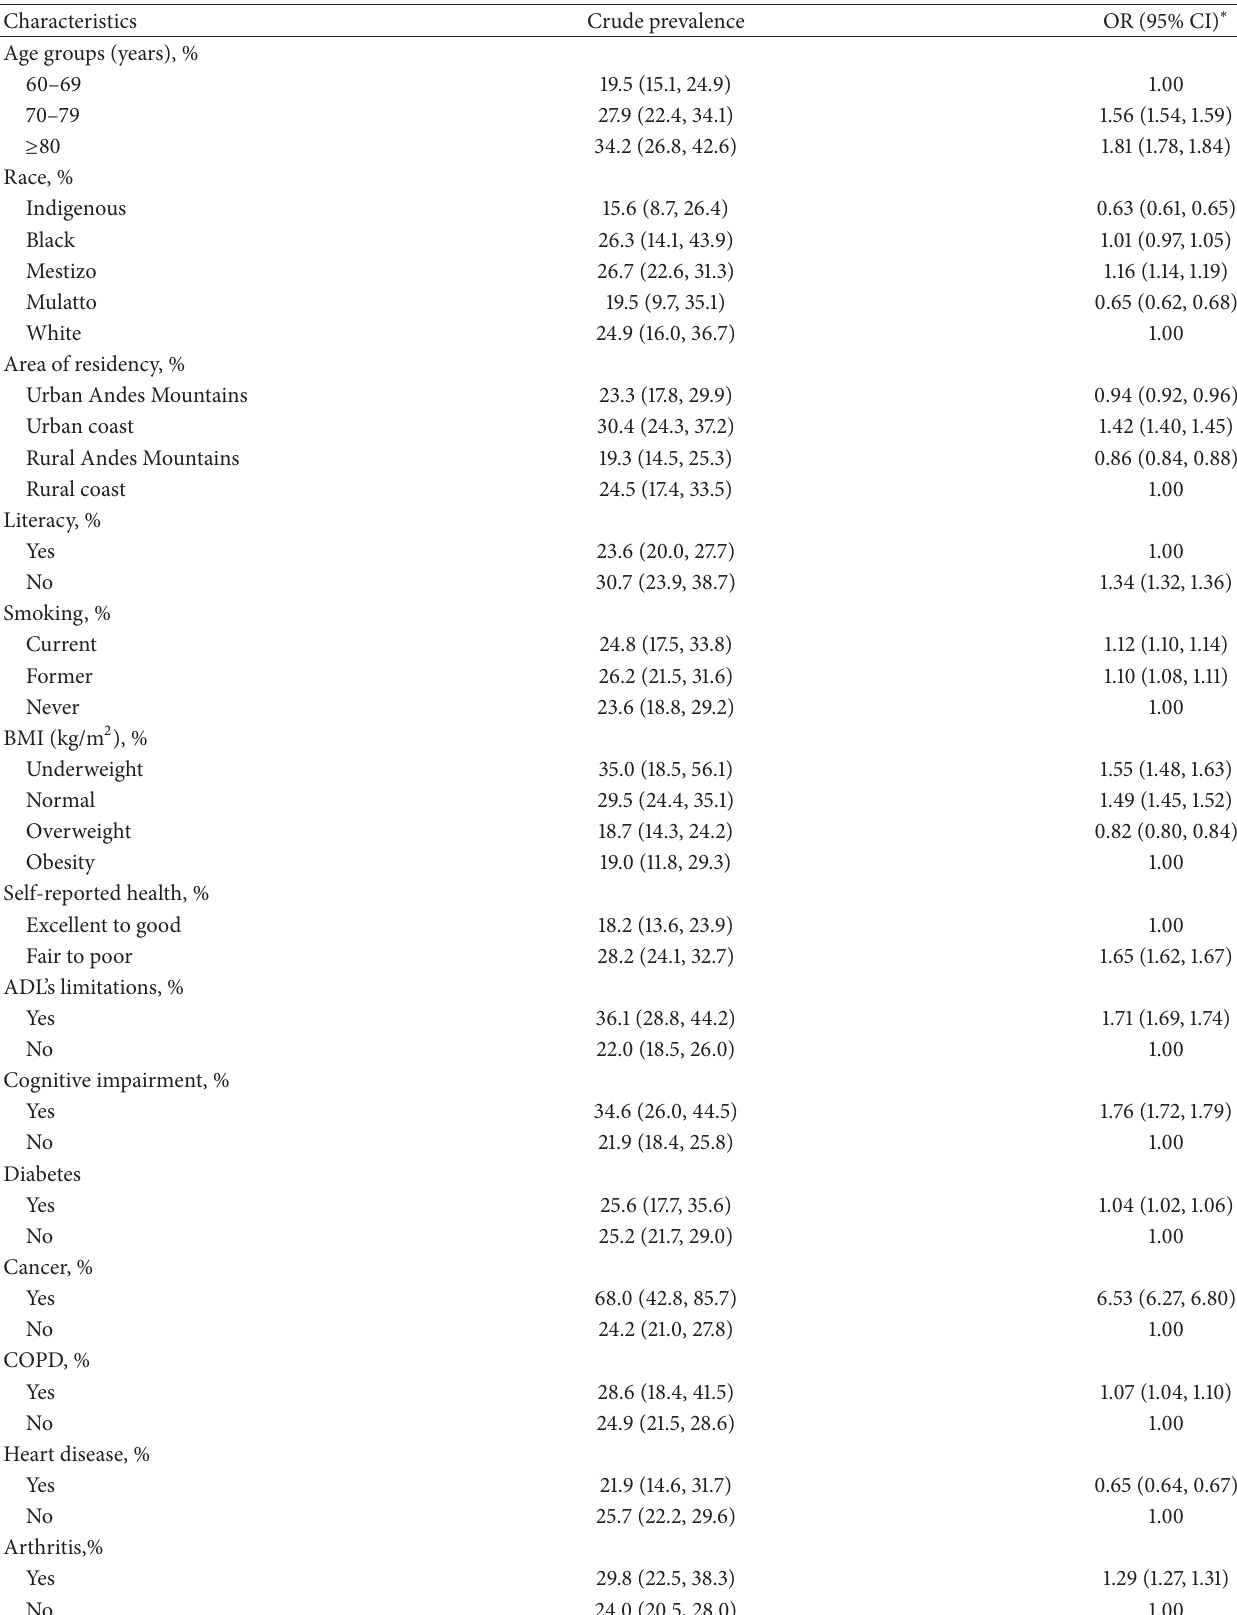
Table 3: Prevalence of anemia among older men in